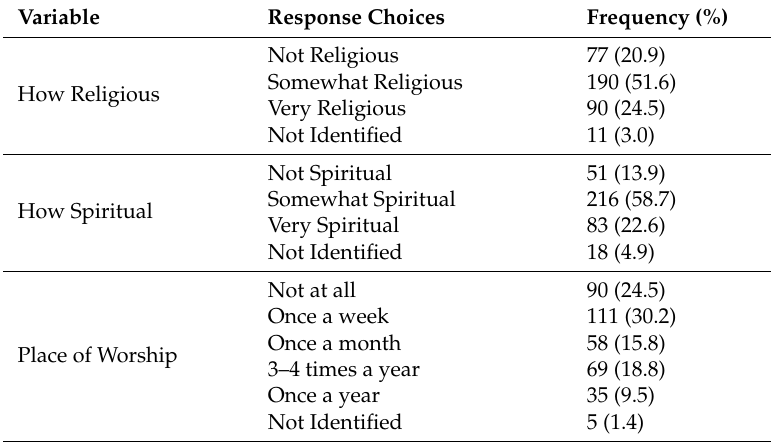
Table 1. Parent-reported demographics and religious and spiritual